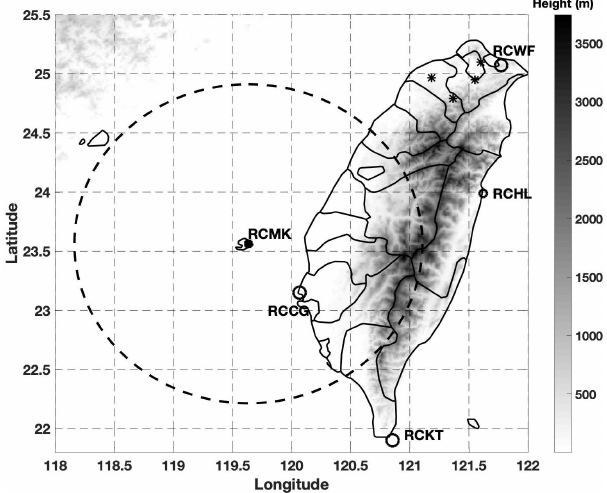
Figure 1. The terrain of Taiwan, the location of a C-band polarimet- ric radar RCMK (marked with a black square), JWDs (marked with black stars), and four S-band single-polarization radars: RCCG, RCKT, RCHL, and RCWF (marked with black circles). The con- tinuous grayscale terrain map shows the central mountain range of